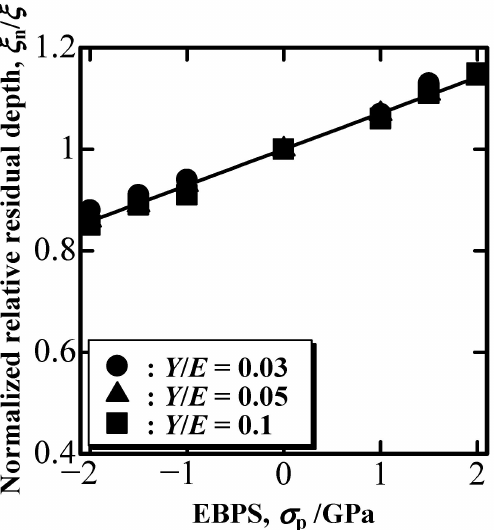
Figure 4. Nominal to EBPS-free relative residual depth ratio, ξ n / ξ , as a function of